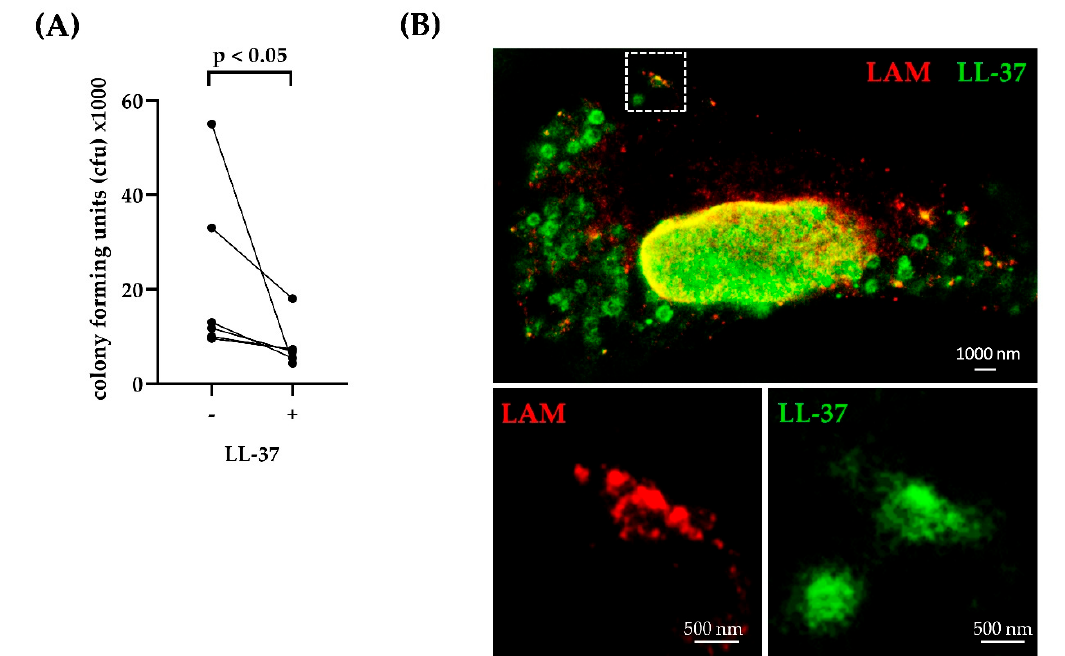
Figure 5. Antimicrobial effect of LL-37-TAMRA against intracellular Mtb . ( A ) Macrophages were infected with Mtb (MOI = 5) for 2 h, followed by incubation with LL-37-TAMRA for 72 h. Afterwards, cells were lysed and plated on 7H11 agar plates to determine mycobacterial growth via colony forming units (CFU). The graph gives the individual results of all six donors investigated. Statistical analysis was performed using a Wilcoxon matched-pairs signed rank test ( p < 0.05). ( B ) Macrophages were infected with unstained Mtb and incubated with LL-37-TAMRA overnight. Internalized Mtb was labelled using an anti-LAM-antibody. Representative area of three different donors is shown. Mtb are depicted via lipoarabinomannan (LAM) in red, LL-37-TAMRA in green. Images were acquired using dual color STED microscopy. Scale bar is 1000 nm for overview images and 500 nm for the shown region of interest.